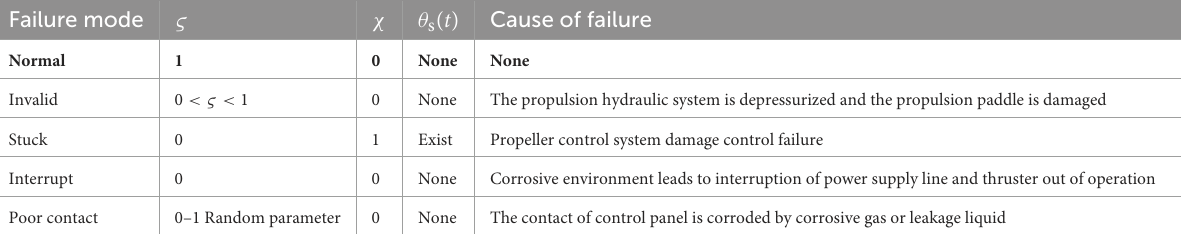
TABLE 1 Propeller failure mode and parameter setting.